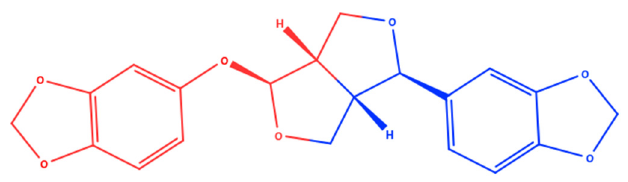
Figure 1. Sesamolin molecular